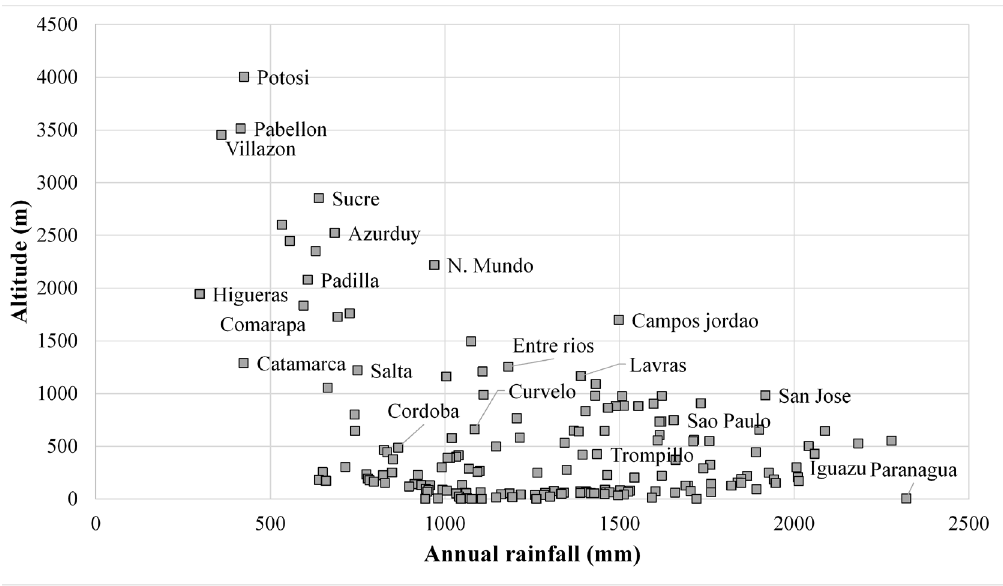
Figure 7. Relation between altitude (m.a.s.l.) and annual rainfall (mm) for the LPB stations.